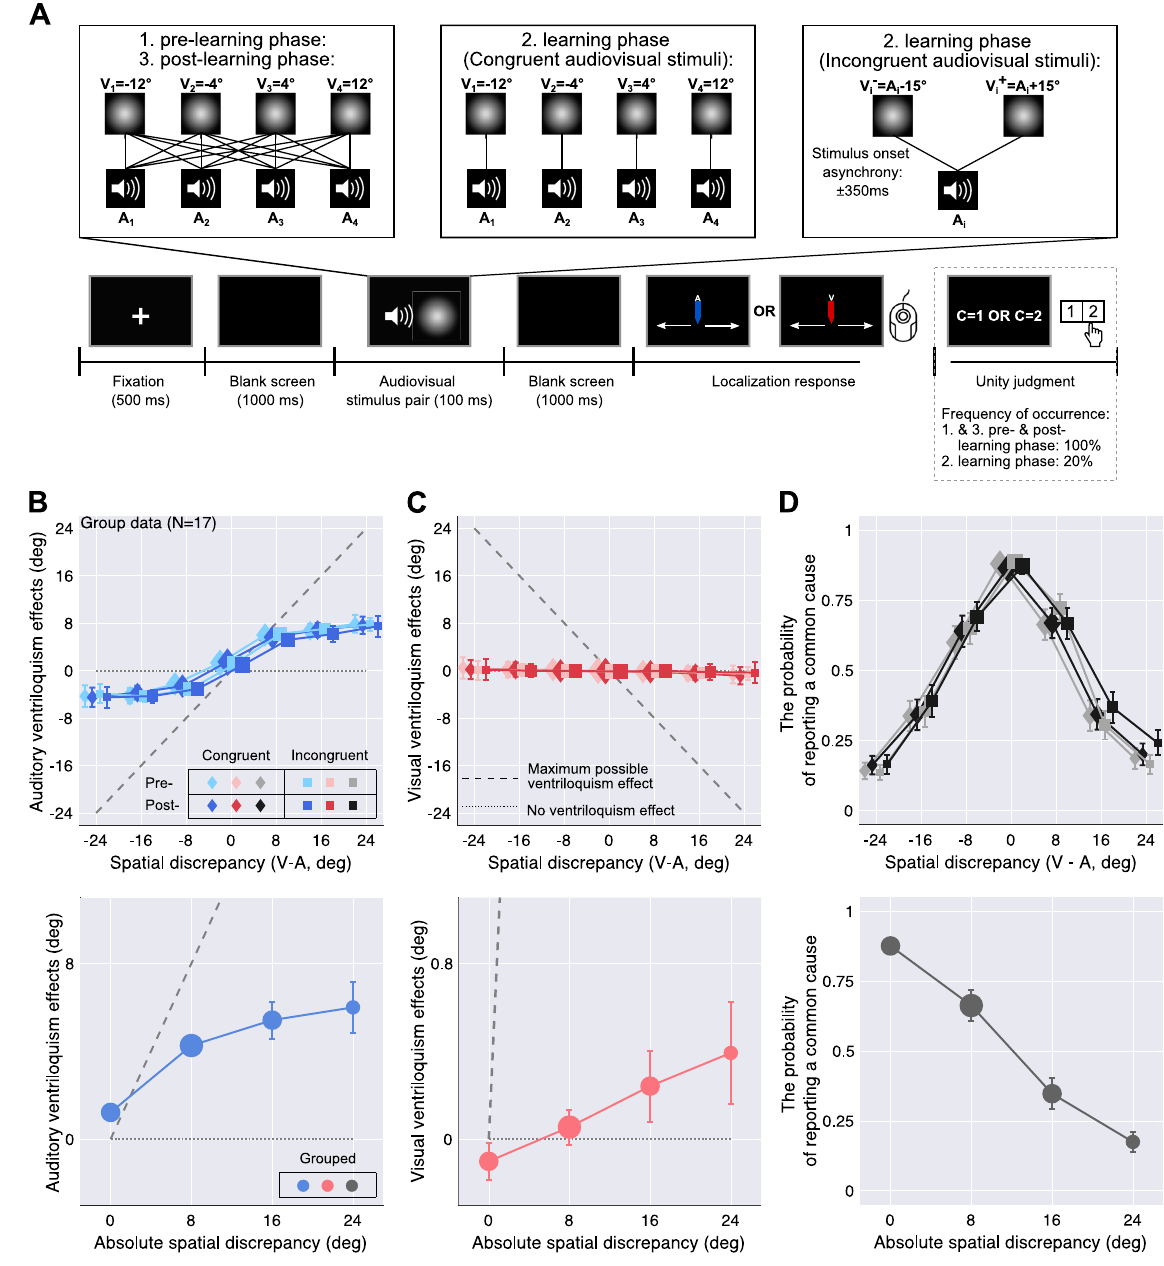
Figure 4. Experimental procedure and behavioral results: bimodal spatial-localization task, main experiment. ( A ) Task timing. Participants were presented with an audiovisual stimulus pair; they indicated the location of one modality specified by a color cue. Subsequently, participants reported whether they perceived the two stimuli to stem from a common source (C = 1) or two separate sources (C = 2) by button press. Sixteen pairs of varying spatial discrepancy were presented during pre- and post-learning phases. Four perceptually matched audiovisual pairs were presented in the congruent learning phase, and 16 spatiotemporally misaligned pairs in the incongruent learning phase. ( B ) Auditory ventriloquism effects, i.e., shifts of auditory localization responses towards the simultaneously presented visual stimulus as a function of spatial discrepancy (top panel) and absolute spatial discrepancy (bottom panel). Data are split by whether the task was conducted before (light hues) or after (darker hues) the learning phase and by the stimulus statistics during the learning phase (marker shape). Error bars: ±SEM. Marker area is proportional to the number of trials. Data are jittered slightly along the x-axis for legibility. ( C ) Visual ventriloquism effects, i.e., shifts of visual localization responses towards the simultaneously presented auditory stimulus. ( D ) The proportion of common-cause reports as a function of spatial discrepancy (top panel) and absolute spatial discrepancy (bottom panel). Note that the y-axis scales are greatly exaggerated in the lower panels of ( B